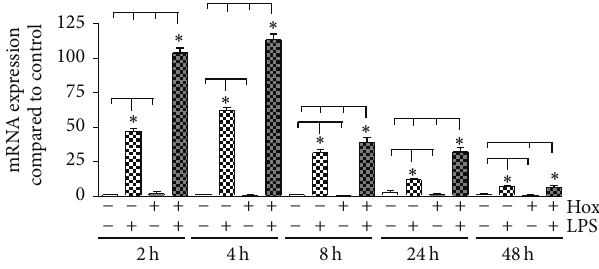
Figure 1: Induction of IL-1 𝛽 mRNA in PDL cells . PDL cells were cultured under normoxic or hypoxic condition and stimulated with LPS-PG (1 𝜇 g/mL). Cells cultured in normoxia without LPS stimulation served as control. IL-1 𝛽 mRNA expression was analyzed by real-time PCR after 2, 4, 8, 24, and 48 h. Statistical differences were analyzed by one-way ANOVA and Dunnett’s test as well as Tukey’s multiple comparison test; ∗ 𝑃 < 0.05 indicates a significant difference between the groups (means ± SD; 𝑛 = 9